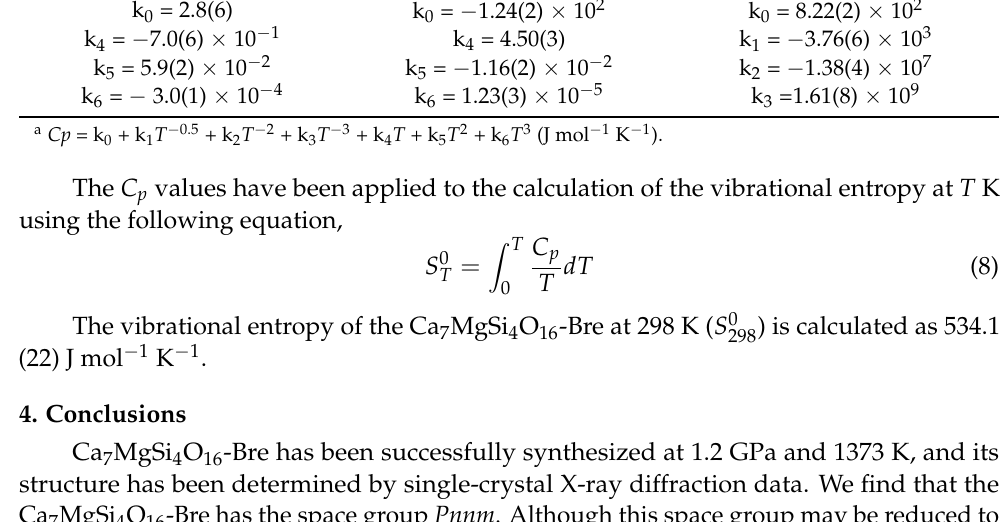
Table 6. Coefficients of the C P polynomials of Ca 7 MgSi 4 O 16 -Bre ( Pnnm ). T Range: 10–100